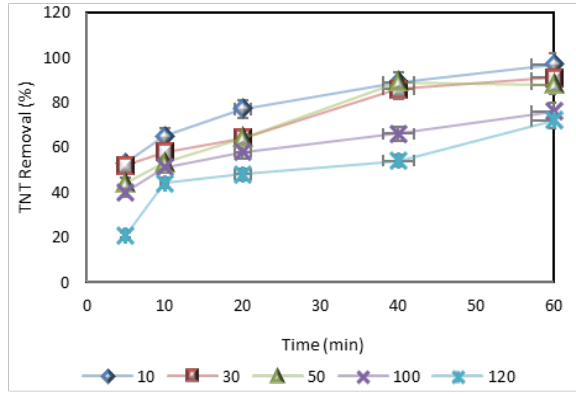
Fig. 5. Efficiency of photo-Fenton process (different concentrations of TNT) in TNT removal at various UV radiation